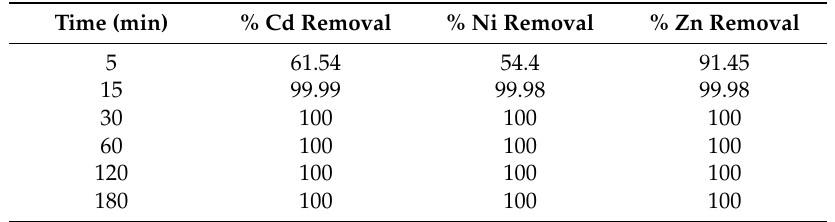
Table 7. Percentage of heavy metals removal from landfill leachate treated with bottom